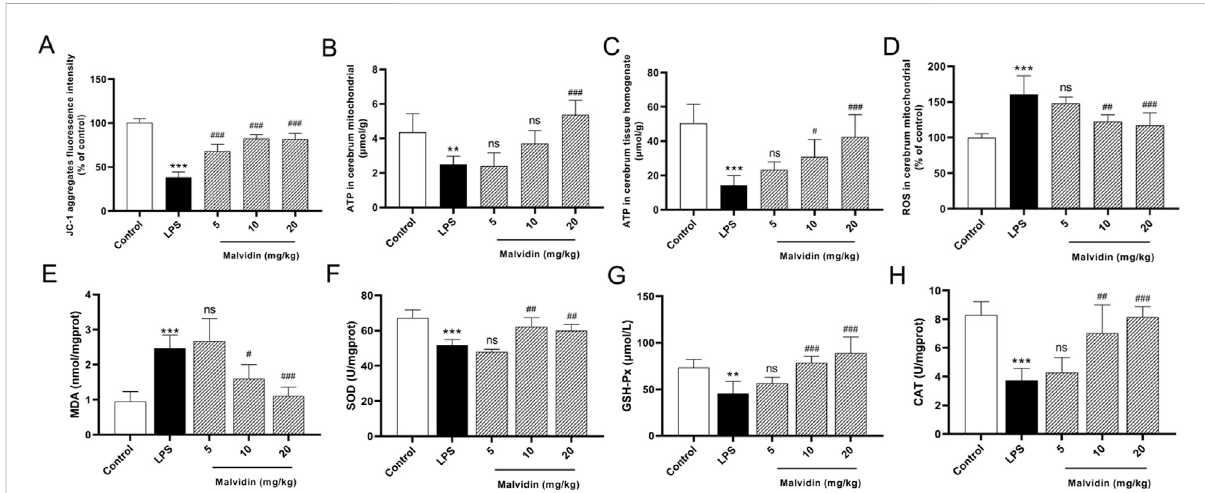
FIGURE 2 Roles of malvidin on LPS-induced mice cerebrum mitochondrial dysfunction and ROS accumulation. (A) JC-1 aggregates fl uorescence intensity in the puri fi ed cerebrum mitochondrial was detected using mitochondrial membrane potential assay kit ( n = 6). (B, C) ATP contents were measured both in the puri fi ed cerebrum mitochondrial and cerebrum tissue homogenates using ATP content assay kit ( n = 6). (D) ROS levels were detected in the puri fi ed cerebrum mitochondrial using ROS assay kit with fl uorescent probe H 2 DCFDA ( n = 6). The MDA contents (E) , SOD activities (F) , GSH-Px activities (G) , CAT activities (H) in cerebrum tissue homogenates were measured using biochemical kits ( n = 6). * represents comparison between LPS group and control group, whereas # indicates analysis among LPS group and malvidin pretreatment groups. # is p <